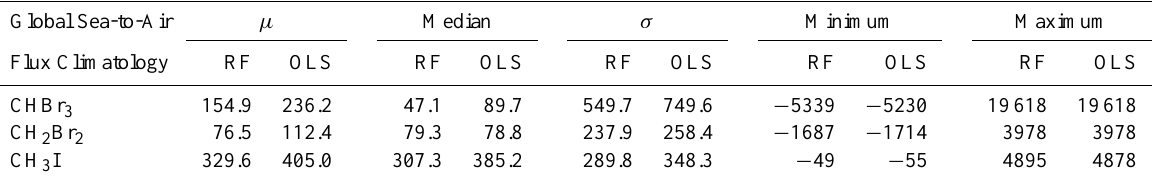
Table 2. Statistical moments: mean ( µ) , median, standard deviation ( σ) , minimum and maximum values for the calculated global sea-to-air flux climatologies of CHBr 3 , CH 2 Br 2 and CH 3 I based on the RF and OLS regression analyses, in pmolm − 2 h − 1 . Global Sea-to-Air